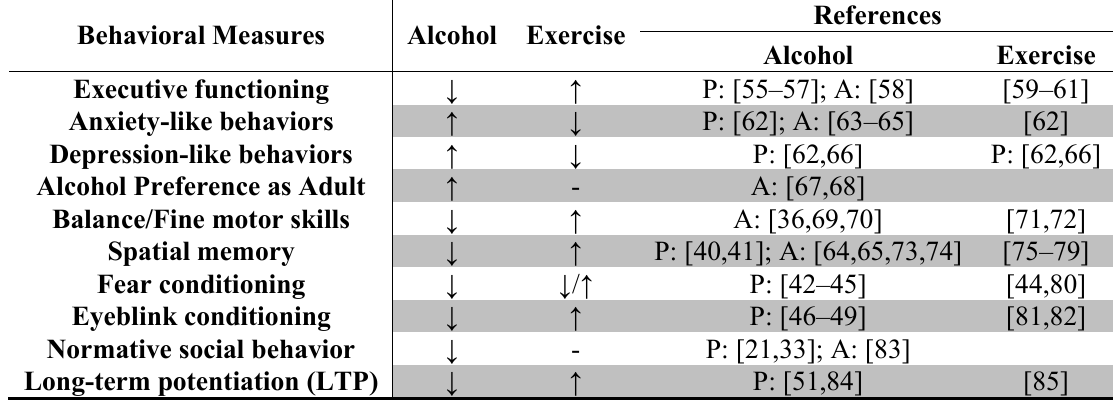
Table 1. Effects of developmental alcohol exposure and aerobic exercise on behavioral measures. Behavioral Measures